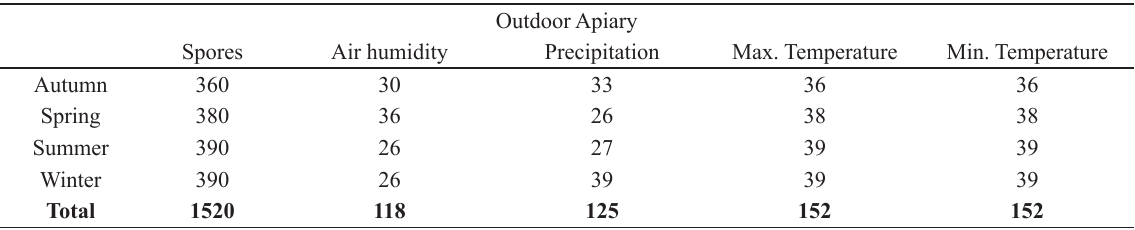
1 . Sampling number (N value) for each studied variable on outdoor apiary: Spores (honey bee samples), air humidity, precipitation, maximum temperature, and minimum